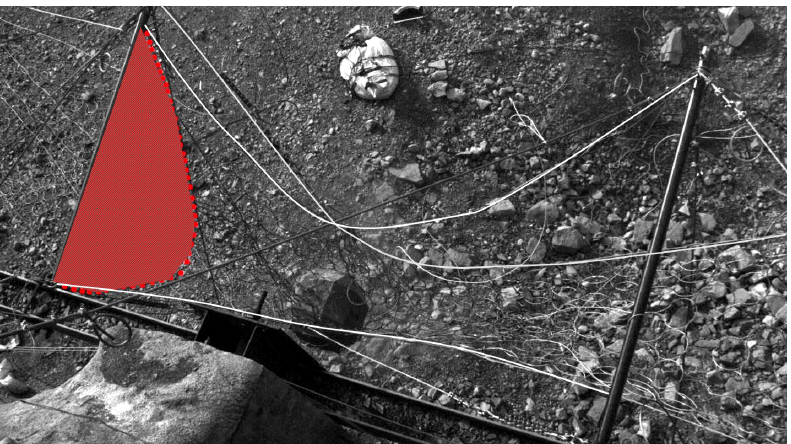
Figure 20. Side hole in the barrier after the lateral impact during the second